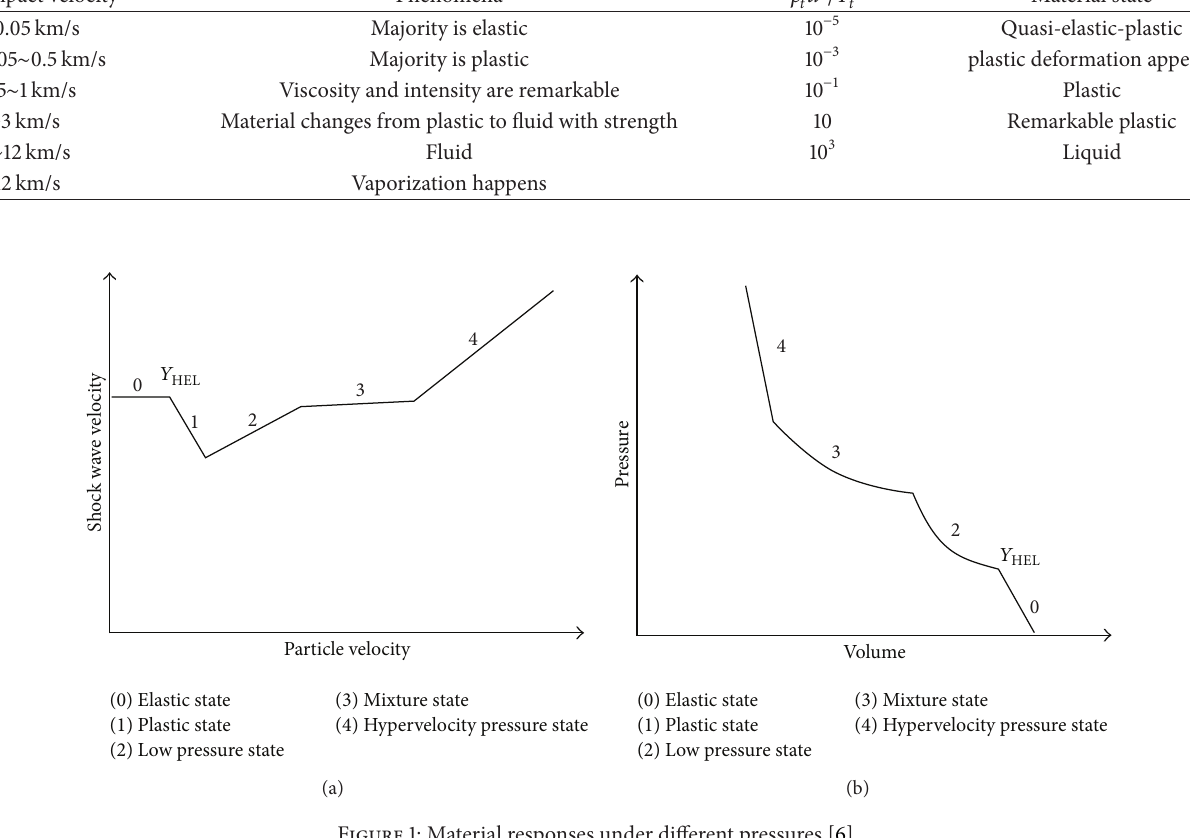
Figure 1: Material responses under different pressures